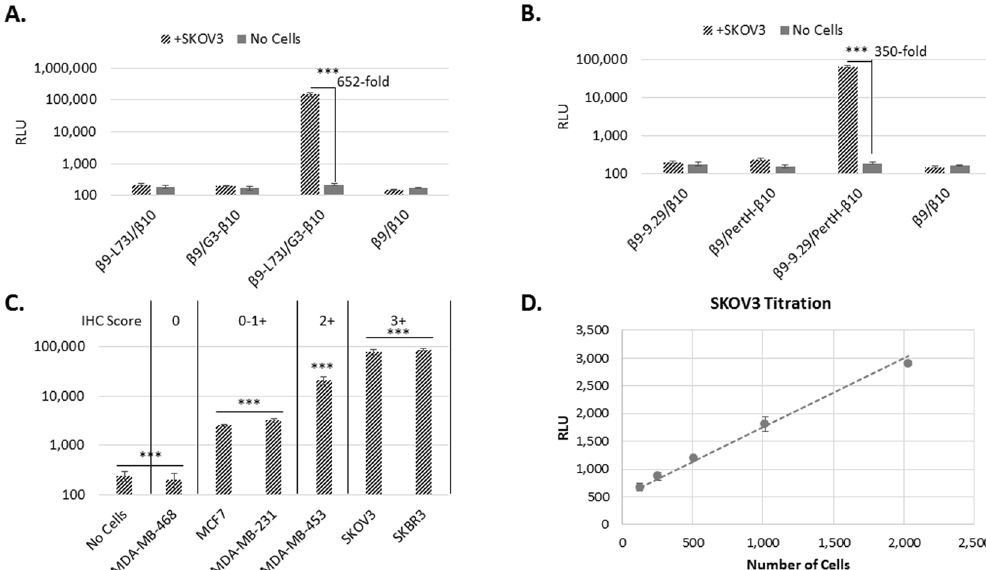
Figure 4. Validation of TEC using purified antibody fusions. TEC with the combination of β 9-L73J and G3- β 10 ( A ) or β 9-9.29 and PertH- β 10 ( B) . None of the fusions alone, nor the combination of synthetic β 9 and β 10 peptides added at the same concentration as the fusions produced significant luminescence. Assay was performed as in the screen of 100 pairs except 100 nM purified binders were incubated with the cells. ( C ) TEC signal (normalized to signal from Cell-titer Glo 2.0 to account for cell number) obtained by incubating with 100 nM β 9-L73J/G3- β 10 for 1 hr, washing 3 times, adding Δ 11S/Nano-Glo substrate (1:20 diluted lysate and 10 μ M, respectively) on various cell lines. Reported immunohistochemistry (IHC) scores for HER2 expression are indicated at top of graph. ( D ) Varying numbers of SKOV3 cells were incubated for 1 hr with a homogeneous TEC detection solution (12.5 nM β 9-L73J, 2.5 nM G3- β 10, 1:20 dilution of Δ 11S lysate, and 10 μ M Nano-Glo substrate). The limit of detection was determined to be 125 cells. All data are averages from three replicate wells with the error bars indicating the standard deviation, *** p <